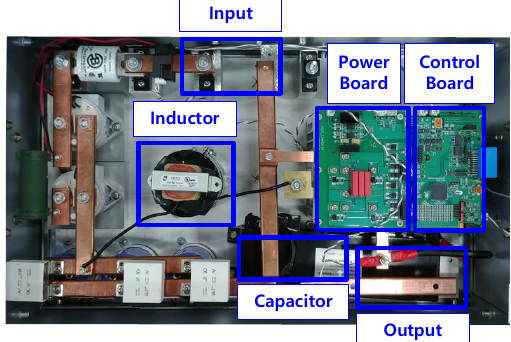
Figure 3. Experimental